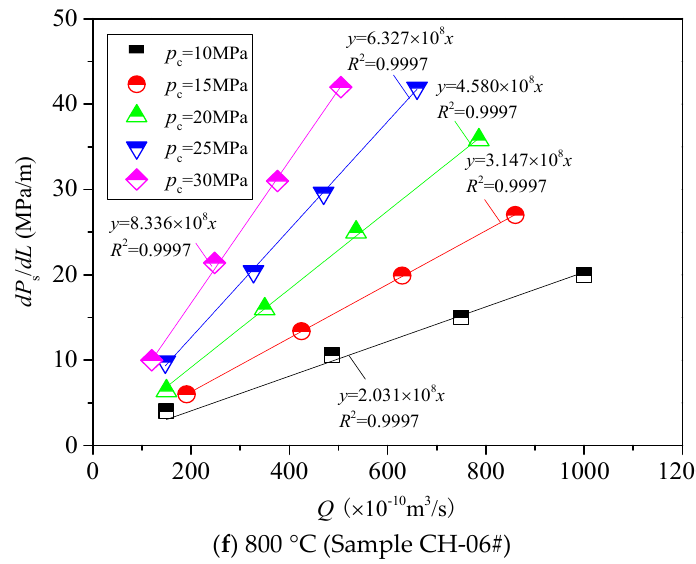
Figure 6. Volume flow rate Q as a function of pressure gradient dP s / dL of the granite samples after high-temperature exposure. ( a ) 200 °C (Sample CH-01#); ( b ) 300 °C (Sample CH-02#); ( c ) 400 °C (Sample CH-03#); ( d ) 500 °C (Sample CH-04#); ( e ) 600 °C (Sample CH-05#); ( f ) 800 °C (Sample CH-06#).